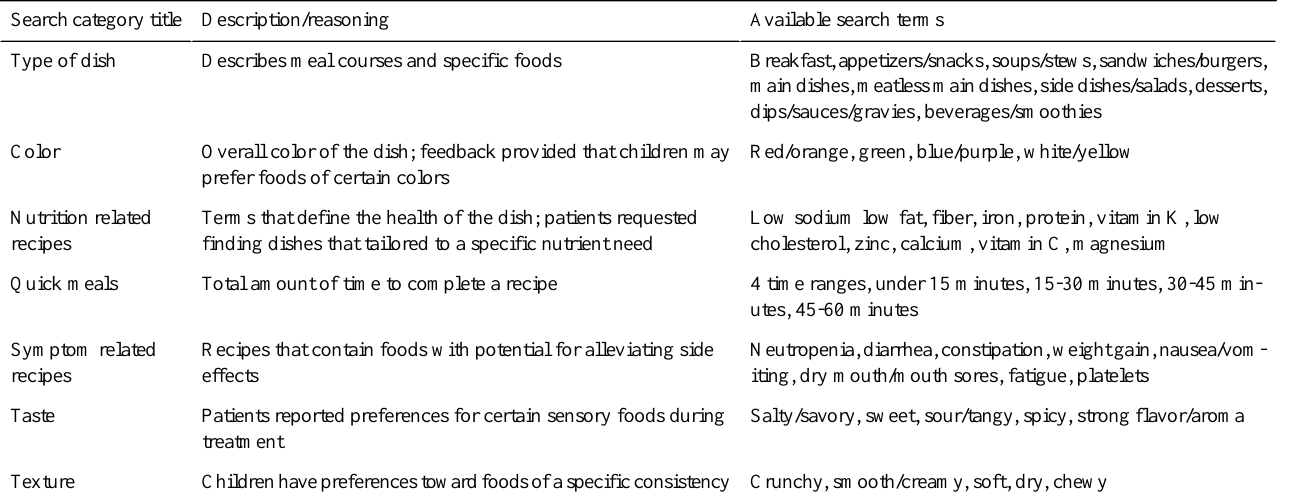
Table 1. Detailed search terms and descriptions available for the “@TheTable” cookbook website.